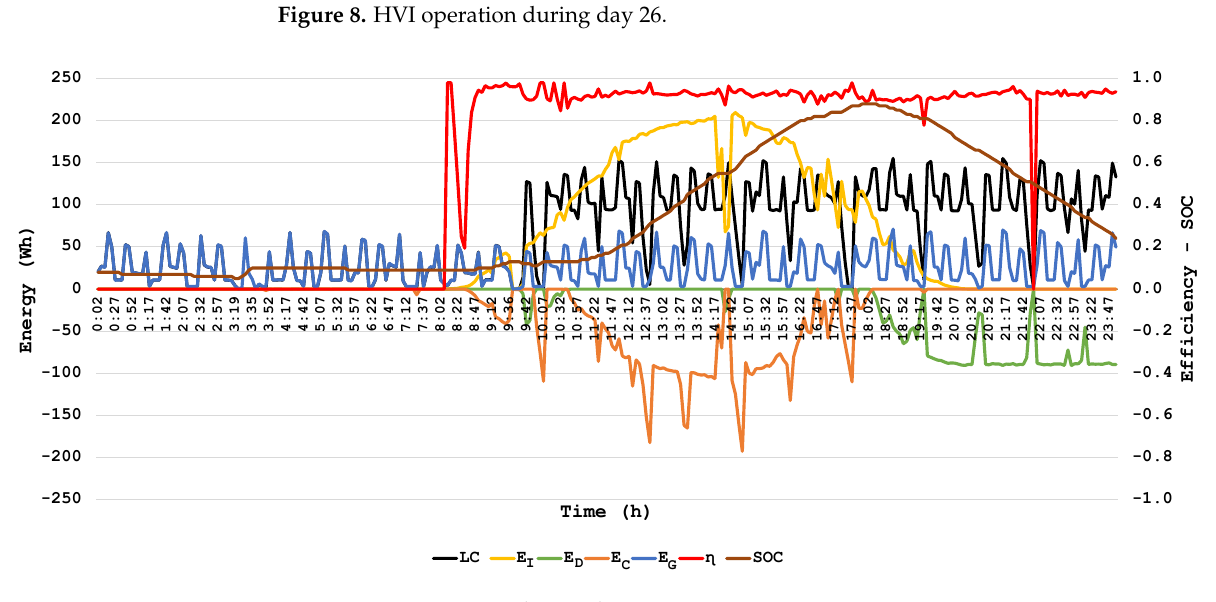
Figure 9. LVI operation during day 26.